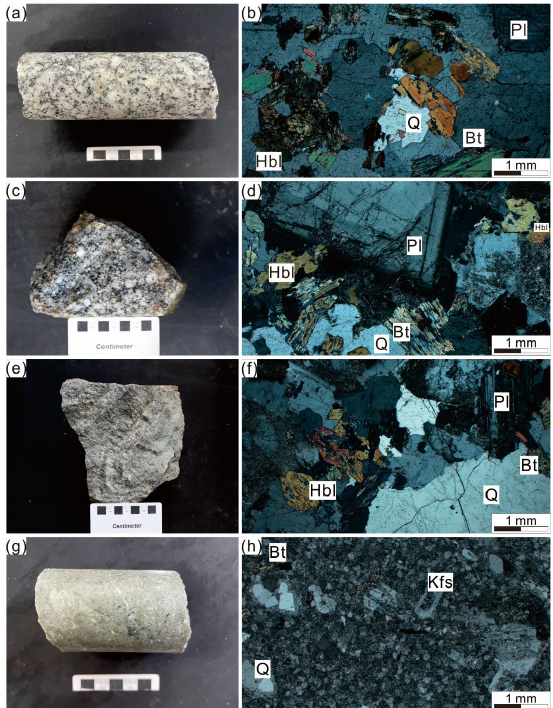
Figure 3. Photos of the Tongshanling granitoids showing variable petrography and textures: ( a ) hand specimen of No. 1 granodiorite; ( b ) photomicrograph of No. 1 granodiorite; ( c ) hand specimen of Jiangyong granodiorite; ( d ) photomicrograph of Jiangyong granodiorite; ( e ) hand specimen of No. 3 granodiorite; ( f ) photomicrograph of No. 3 granodiorite; ( g ) hand specimen of granite porphyry; ( h ) photomicrograph of granite porphyry. Bt, biotite; Hbl, hornblende; Kfs, K-feldspar; Pl, plagioclase; Q,